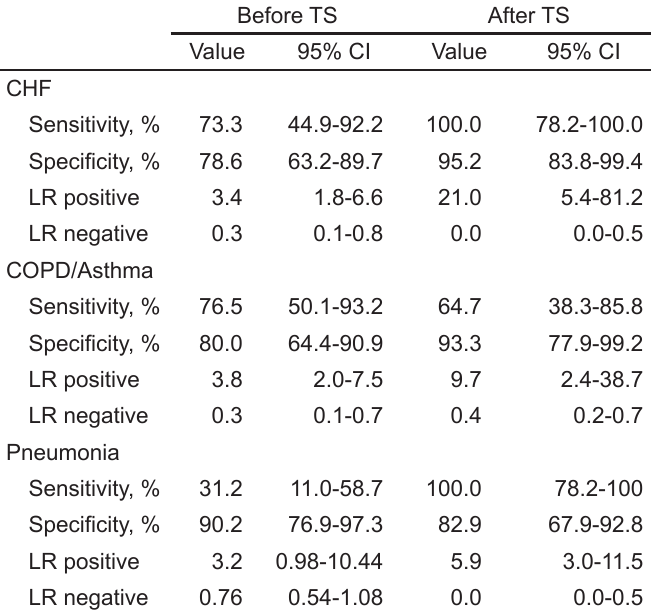
Table 3. Test characteristics for treating physician primary impression, before and after “triple scan”